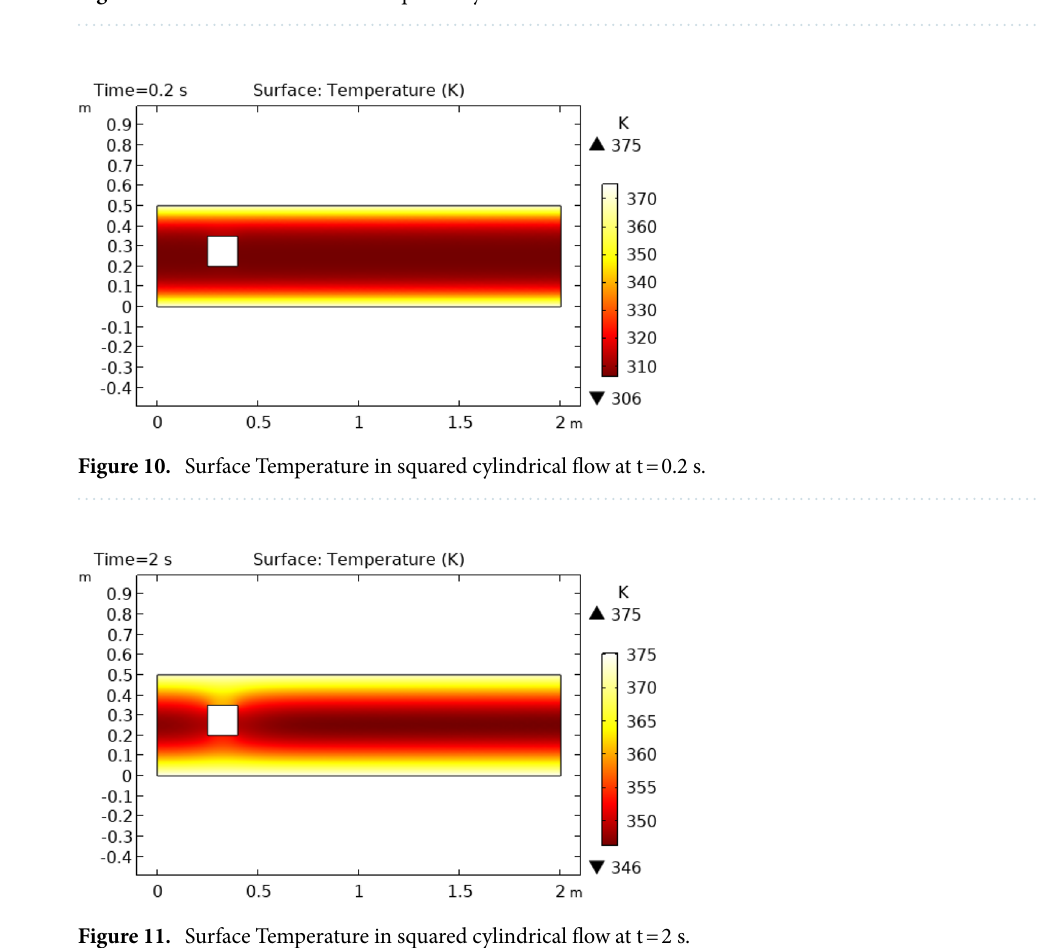
Figure 9. Pressure distribution in squared cylindrical flow at t = 5.4 s.